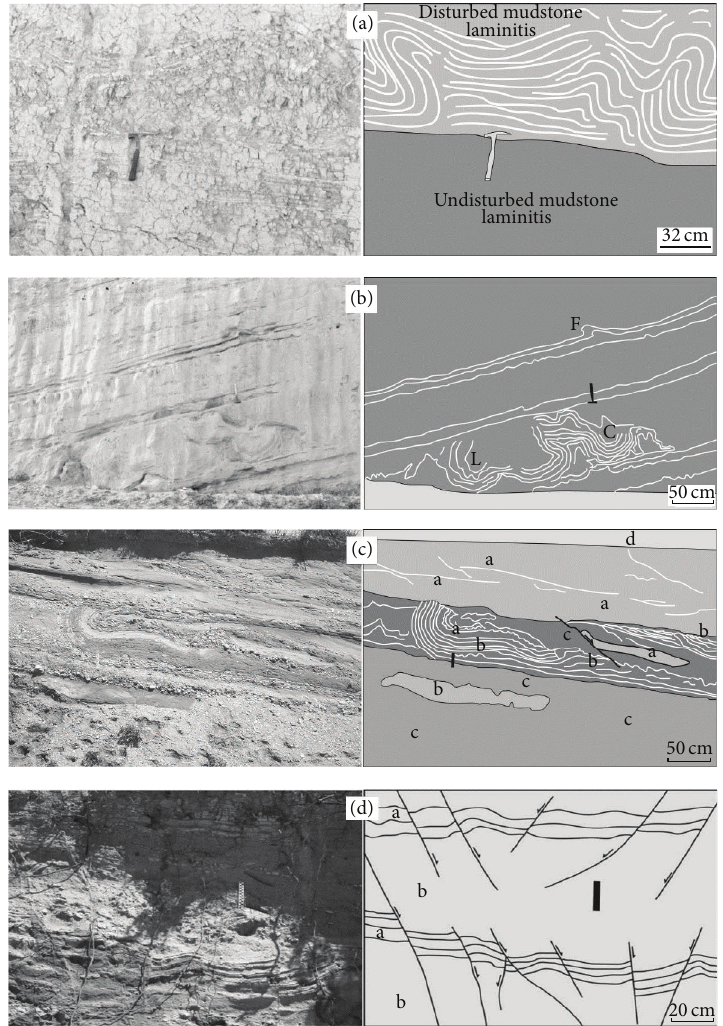
Figure 6: Other soft-sediment deformation structures: (a) disturbed laminitis (37.804 N, 29.132 E), (b) convolute laminations (F: Flame structures, L: Load casts, and C: Laminated convolute beds) (37.807 N, 29.115 E), (c) slump structure (a: coarse-grained sands, b: fine-grained sands, and c: gravelly unit) (37.765 N, 29.144 E), (d) synsedimentary faults (a: calcarenite, b: sand) (37.754 N, 29.178